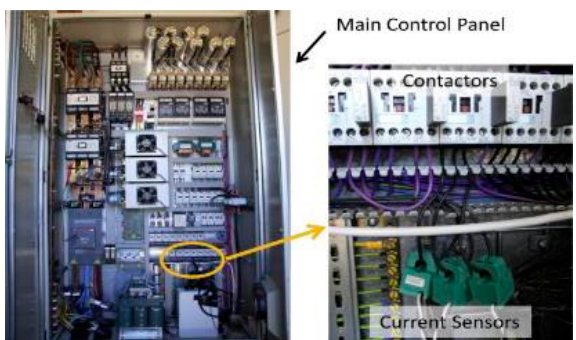
Figure 6. The current sensors for the brake hydraulic system inside the main control panel of the WT Reproduced with permission from [42]. Elsevier, 2012.